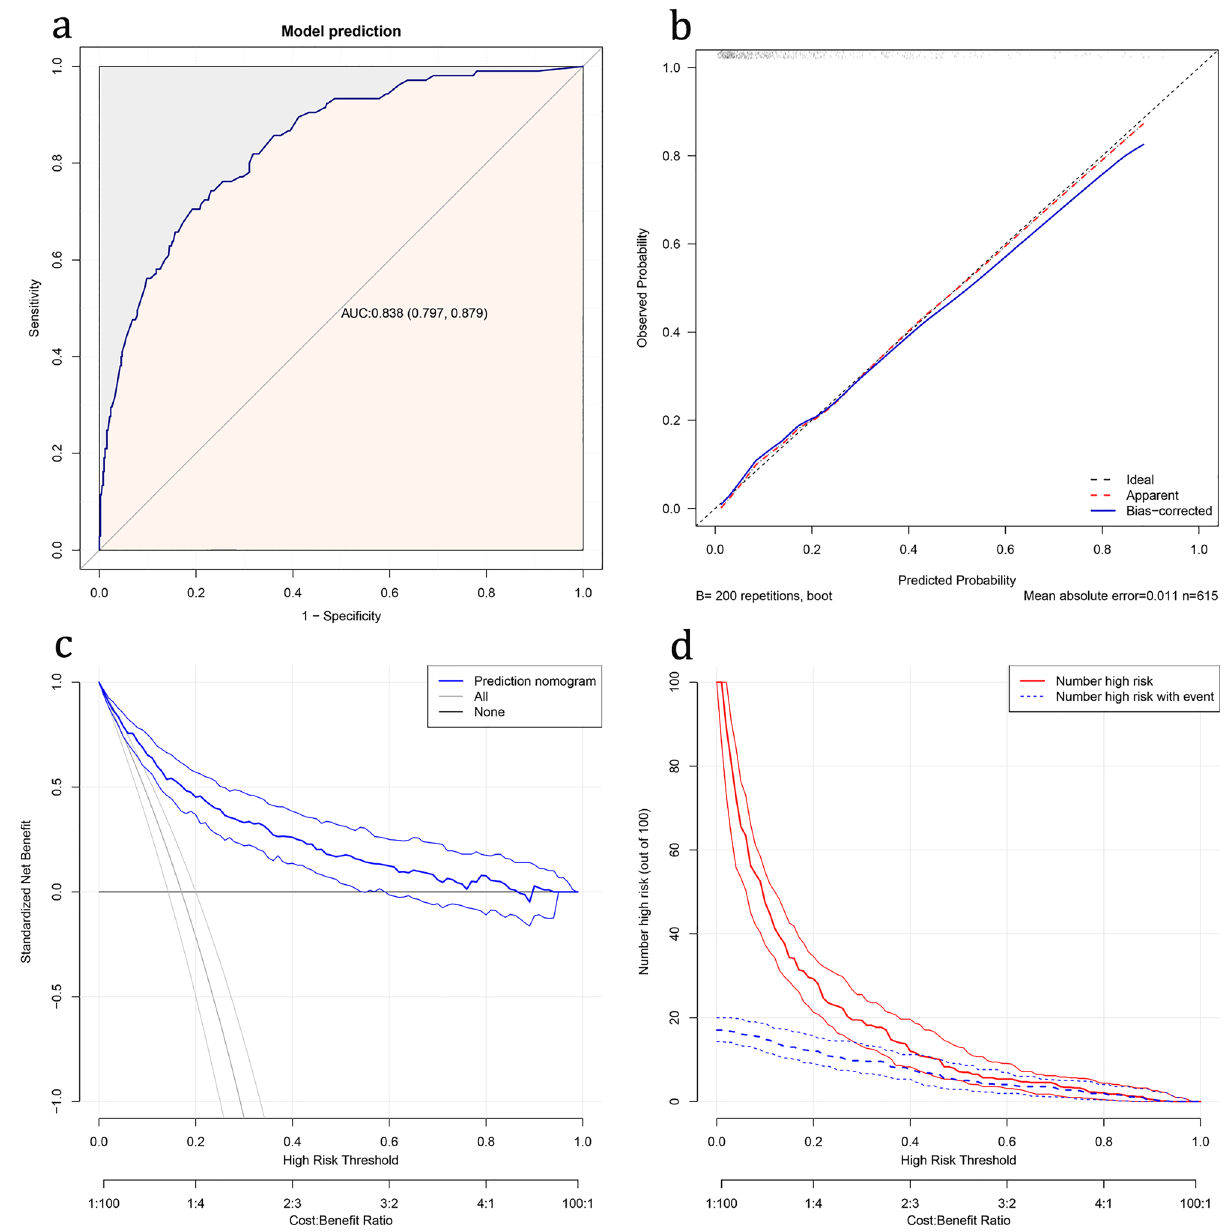
Figure 3. Nomogram validation. ( a ) ROC curve for the nomogram. ( b ) Calibration curve for the nomogram. The x-axis represents the predicted 1-year mortality risk. The y-axis represents the actual confirmed 1-year mortality. The diagonal dotted line represents a perfect prediction by an ideal model. The solid line represents the performance of the nomogram, of which a closer fit to the diagonal dotted line represents a better prediction. ( c ) Decision curve analysis for the nomogram. The y-axis measures the standardized net benefit. The blue line represents the nomogram and its 95%CI. The thin solid line represents the assumption that all patients die within 1 year. The thick solid line represents the assumption that no patients die within 1 year. ( d ) Clinical impact curve for the nomogram. The solid red line represents the predicted number of people and 95% CI judged as high risk by the model at different risk thresholds. The dotted blue line represents the actual number of high-risk people and 95% CI at different risk